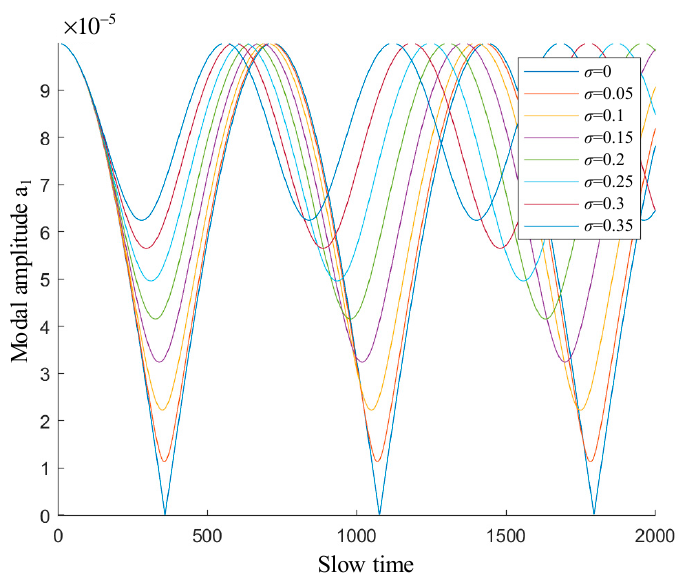
σ Figure 7. Influence of σ on modal amplitude a 1 . a . Figure 7. Influence of on modal amplitude 1 The maximum change in modal amplitude a 1 is measured, as shown in Table 3. From a is measured, as shown in Table 3. this, the change curve of the energy transfer capacity with respect to different values of σ 1 is obtained, as shown in Figure 8. The change curve reaches its peak when σ = 0 and is approximately symmetrical on both sides of the peak. Taking the curve’s half power point √ on both sides of the peak, the ordinate is ∆ a 1max / 2, and the corresponding detuning parameters are obtained as σ 1 and σ 2 , respectively. Thus, the adequate working bandwidth (i.e., ( − 1.4, 1.4)) is large, which verifies that the system’s robustness is strong enough. Table 3. Influence of σ on modal amplitude